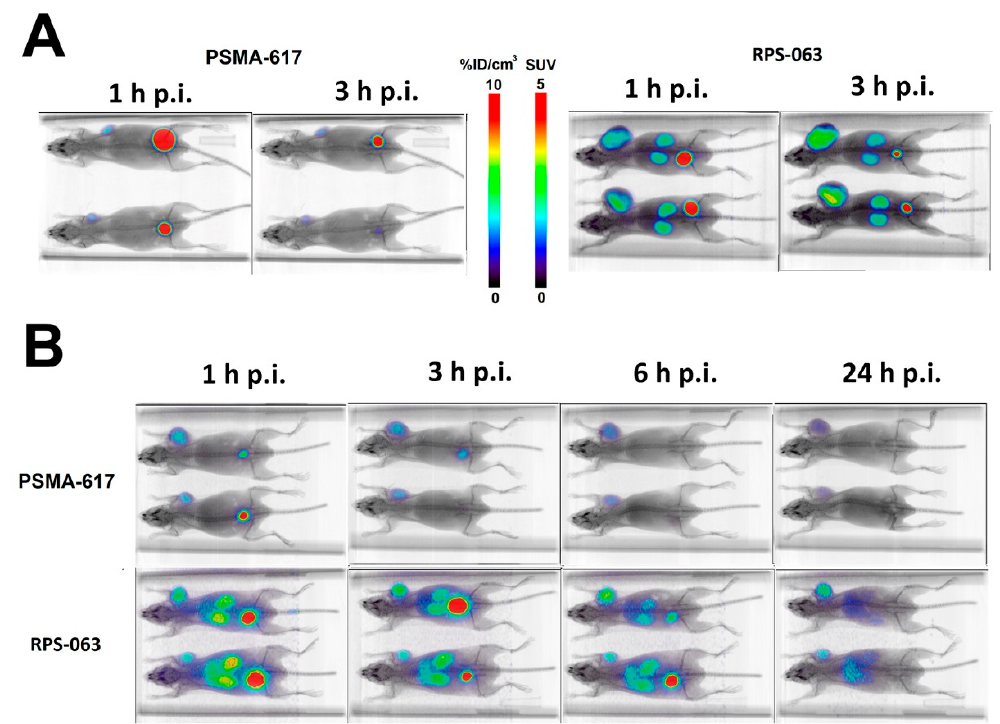
Figure 3. Comparison of µPET/CT images of [ 66/68 Ga]PSMA-617 and [ 66/68 Ga]RPS-063 in LNCaP xenograft tumor-bearing mice. Mice were injected with a bolus injection of ( A ) 8.9–11.1 MBq [ 68 Ga]PSMA-617 or [ 68 Ga]RPS-063, or ( B ) 1.3–1.7 MBq [ 66 Ga]PSMA-617 or [ 66 Ga]RPS-063, and imaged under isoflurane for 30 min (1 h, 3 h, and 6 h) or 60 min (24 h). Time-activity curves (TACs) were derived for [ 66/68 Ga]PSMA-617 and [ 66/68 Ga]RPS-063 in tumors